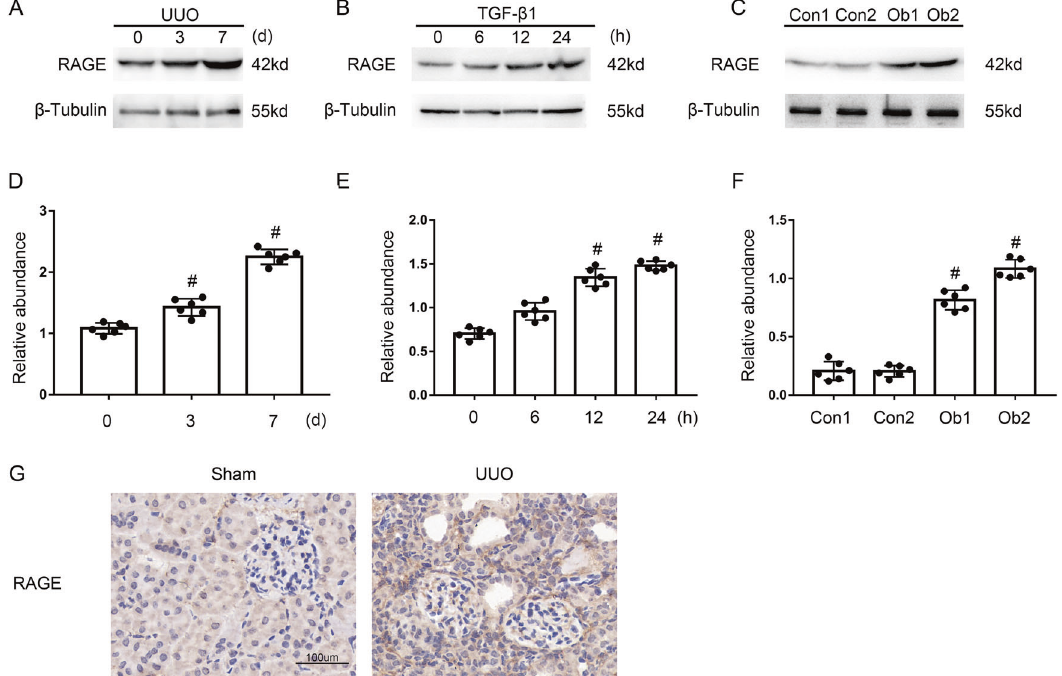
grayscale image between them. G Immunohistochemical staining of RAGE in the kidney of the Sham or UUO mice. Original magni fi cation×400. Scale bar: 100 µM. Data are expressed as means ± s.d. ( n = 6). # P < 0.05 versus 0 d & 0 h and Con group. Each